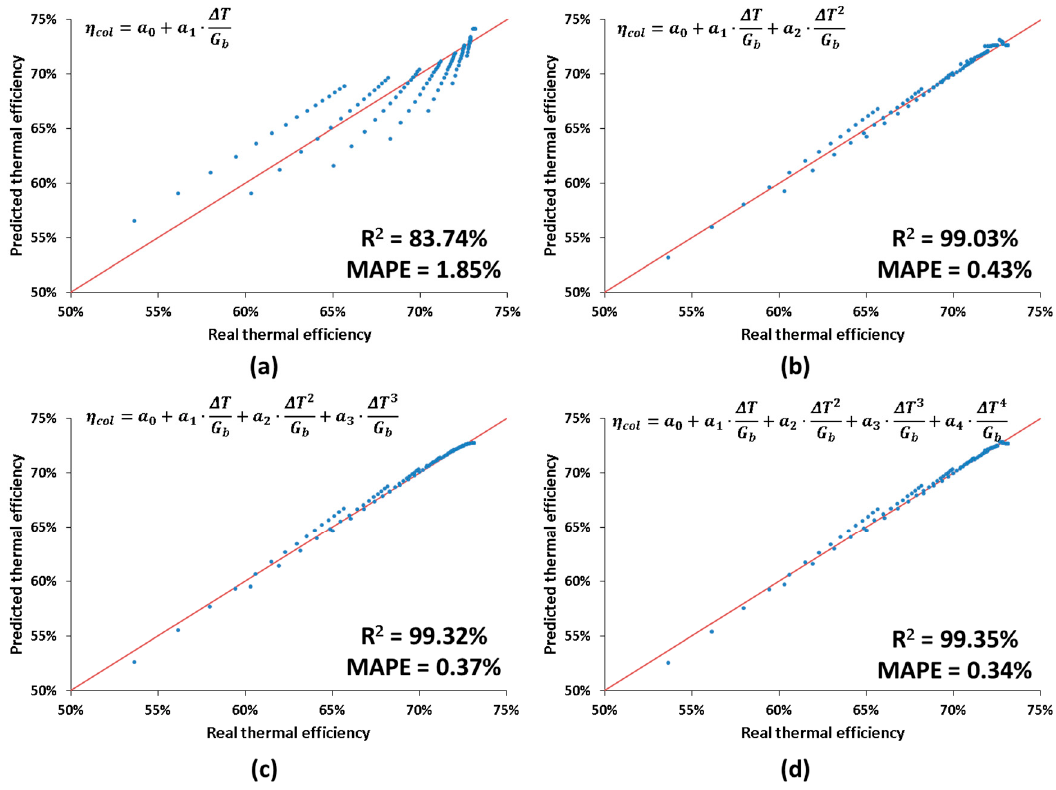
(cid:80) ( a m · ∆ T m / G b )” ( a ) [ a 0 , a 1 ]